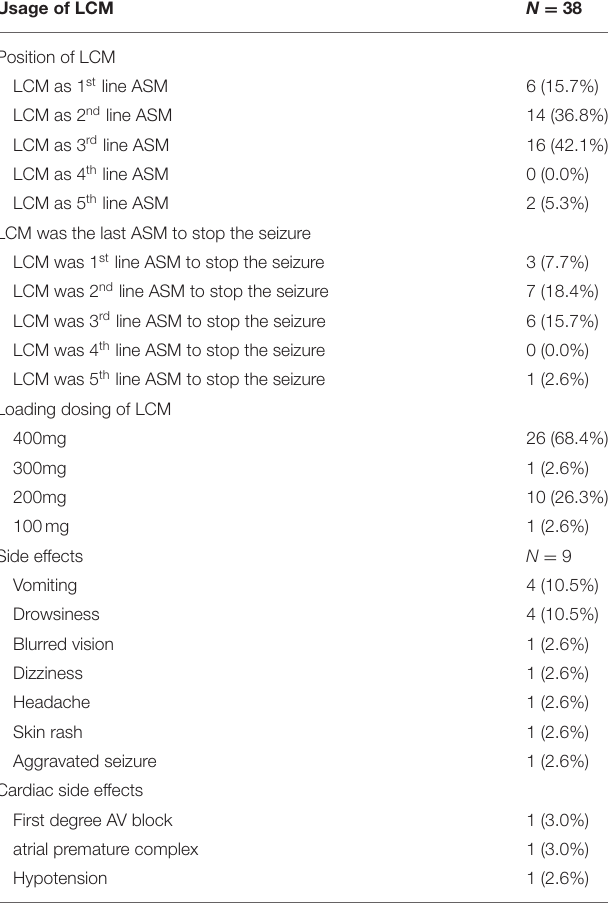
TABLE 2 | Concomitant use of other medications at the initiation of lacosamide. Medication